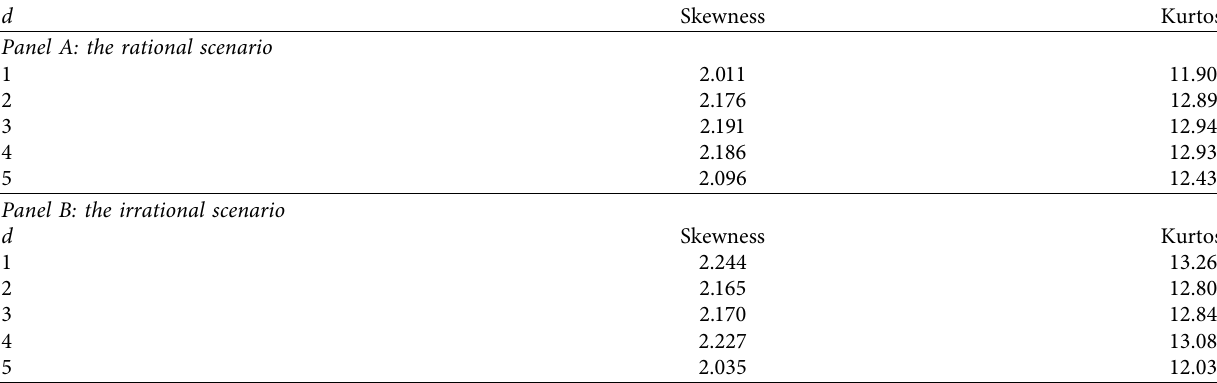
Table 8: Skewness and kurtosis of returns after calibration. Note: We present the skewness and kurtosis of returns in this table. Panels A and B, respectively, show outcomes for the rational and irrational circumstances. d denotes the strength in regard to the behavioral hesitation and decision rigidity of the anxious agent.